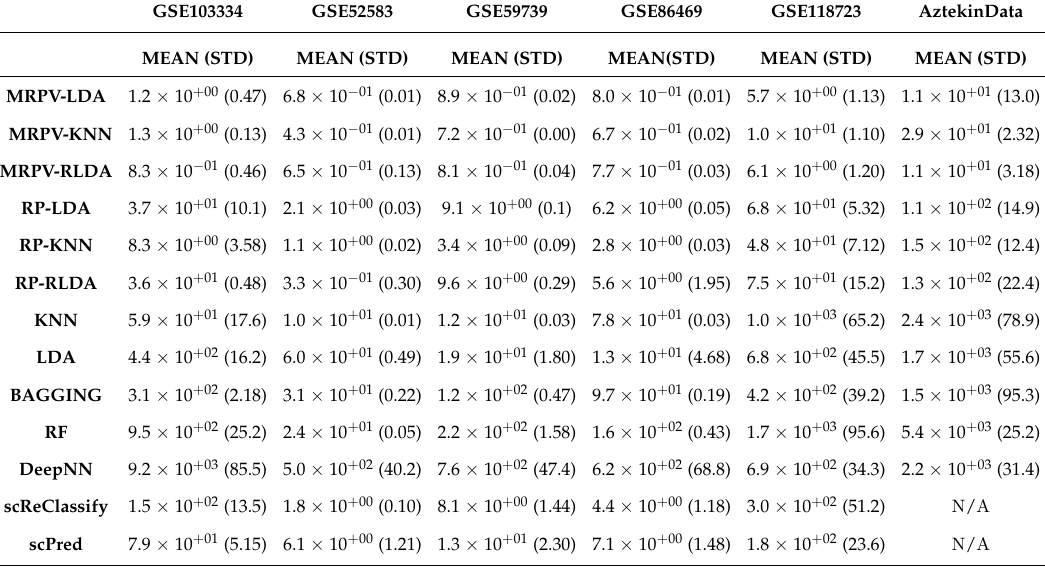
Table 2. Mean and standard deviation (STD) values of the computational time performance of MRPV frameworks along with the other ten similar algorithms used as comparative evaluation in the current work. All algorithms have been executed 100 times independently for all six single-cell RNA-seq dataset (scReClassify and scPred were not applicable to AztekinData, due to the high computational demands). It is observed that our framework has the shortest execution times, especially the MRPV-KNN. Τ his confirms the simplicity and the low computational effort required in random projections. Although in the RP-based algorithms one random projection is applied, our model is faster since, based on our assumptions, we perform projections in extremely small dimensions, where the simple random projection method cannot guarantee its